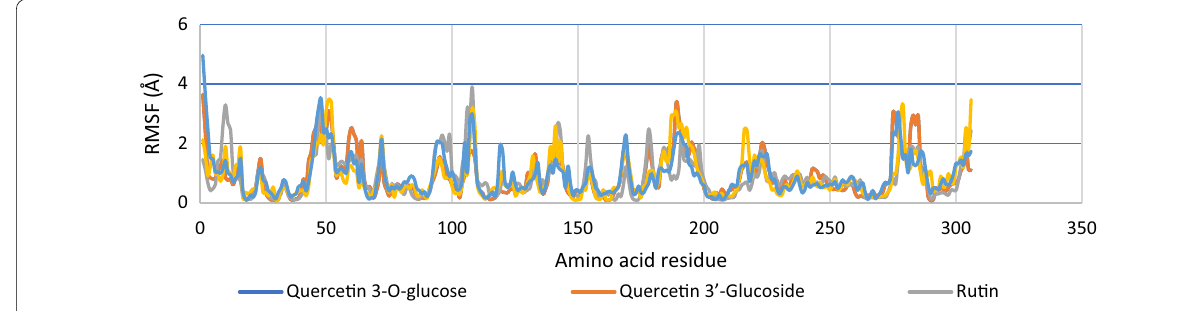
Fig. 5 Root mean square fluctuations in protein structures in response to specific substrates